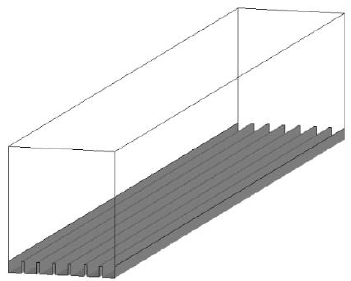
Figure 6. Rectangular groove plate model.